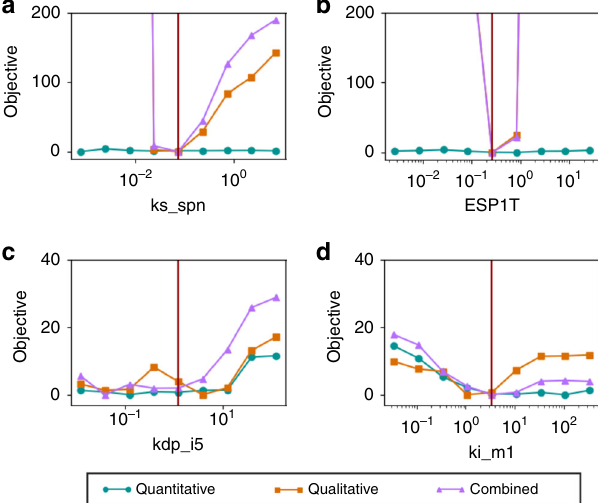
Fig. 5 Pro fi le likelihood uncertainty quanti fi cation. We calculated pro fi le likelihood for selected parameters in the yeast model: a ks_spn, b ESP1T, c kdp_i5, d ki_m1. For each parameter, we compare the pro fi les generated from only quantitative data (blue circles), only qualitative data (orange squares), or both datasets combined (purple triangles). Sampling of the pro fi les was coarse due to the computational cost of fi tting. At each point shown, we performed fi ve replicates of the optimization and took the best result. Each pro fi le was normalized to zero by subtracting the minimum value. The vertical, red lines indicate our best- fi t value for each